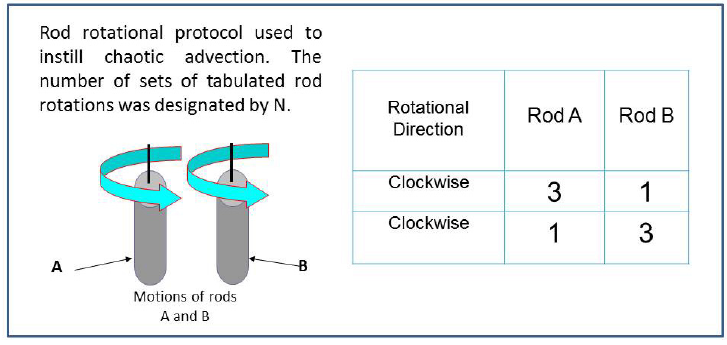
Figure 2. Schematic presentation of the agitator in chaotic advection and the time evolution of the slow. The agitation scheme used in the current study for N = 1 is